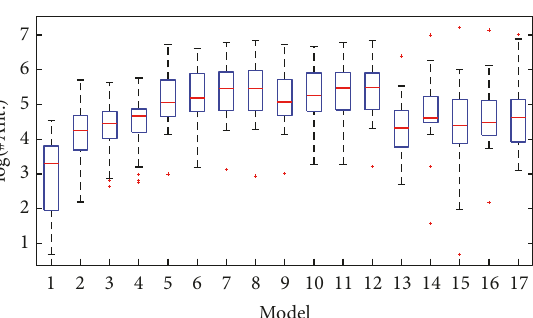
Figure 6: Boxplots of the average log-complexity of the extracted rulesets ( 𝑦 -axis) with respect to each model ( 𝑥 -axis). Complexity corresponds to the number of rule antecedents per ruleset. With respect to the 𝑥 -axis indexes 1 to 4 indicate BST-M with split parameter varying from 1 to 4, indexes from 5 to 8 are related to BST-G, indexes from 9 to 12 indicate BST-R results, and finally indexes from 13 to 17 correspond to DIMLP-B, DIMLP-A, QSVM-L, QSVM-P3, and QSVM-G,